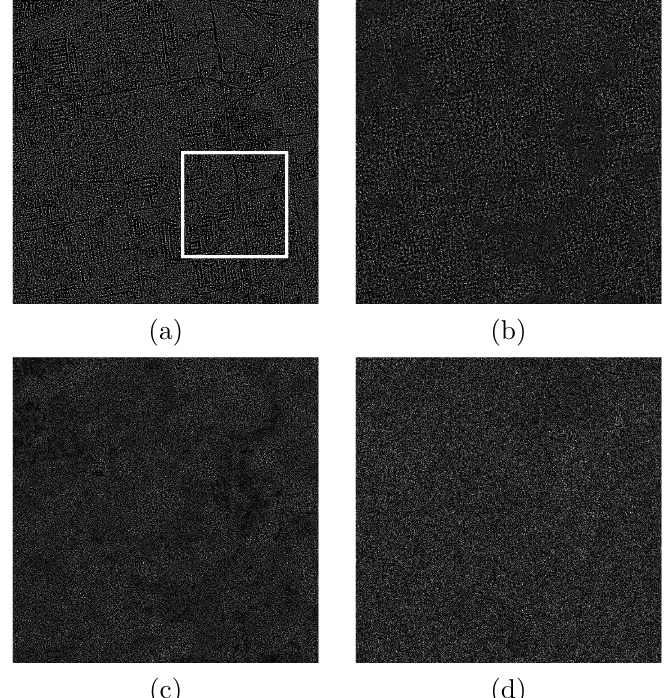
Figure 19. Chicago test case. Ratio images obtained after proceeding with the filtering algorithms: